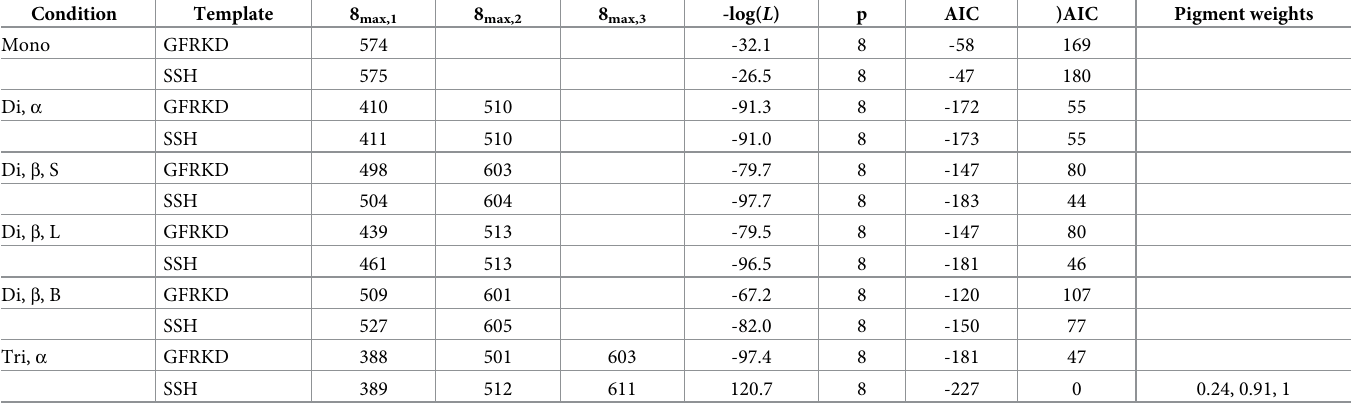
Table 4. The spectral sensitivity of European seabass fed diets with reduced taurine levels (i.e., 0 and 1.5%) where the data from fish in these two groups have been combined. Condition